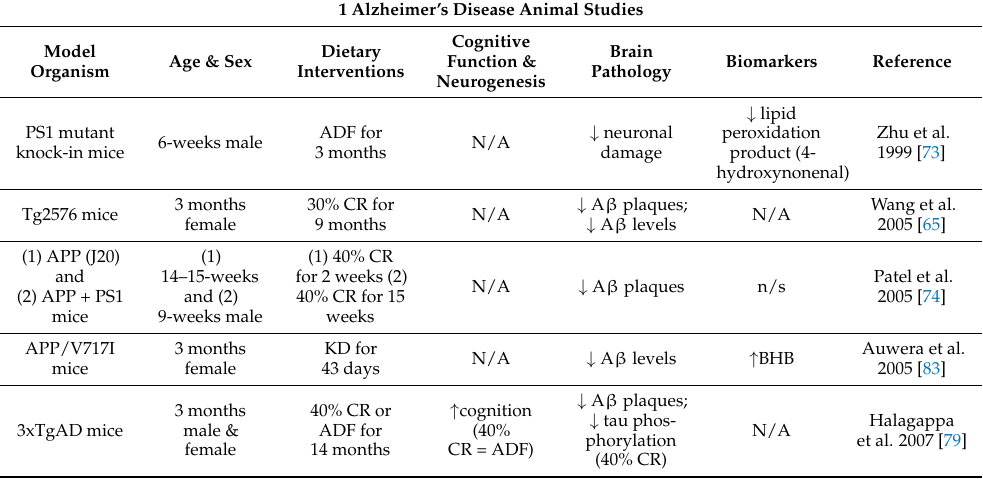
Table 1. All reviewed studies investigating the effects of DR in AD. N/A: relevant data not reported; n/s: relevant data not significant; A β : amyloid beta; BHB: beta-hydroxybutyrate; GFAP: glial fibrillary acidic protein; PRCs: protein restriction cycles; IGFBP-1/3: insulin growth factor binding protein- 1/3; IGF-1: insulin growth factor-1; GSK-3 β : Glycogen synthase kinase-3 beta; PKA: protein kinase A; NOX2: NADPH oxidase 2; MCI: mild cognitive impairment; aMCI: amnestic mild cognitive